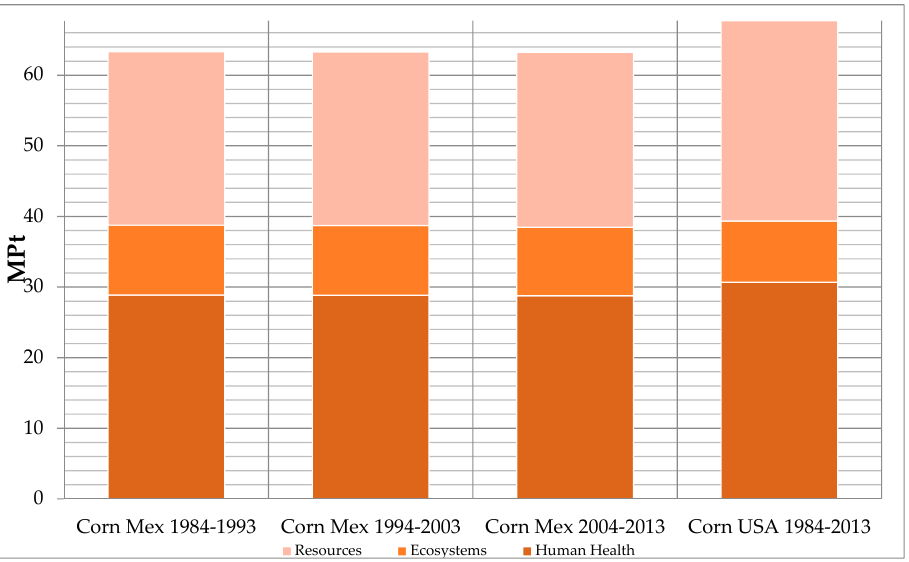
Figure 2. Life cycle analysis normalized by functional unit by the ReCiPe Endpoint (H) V1.10/World